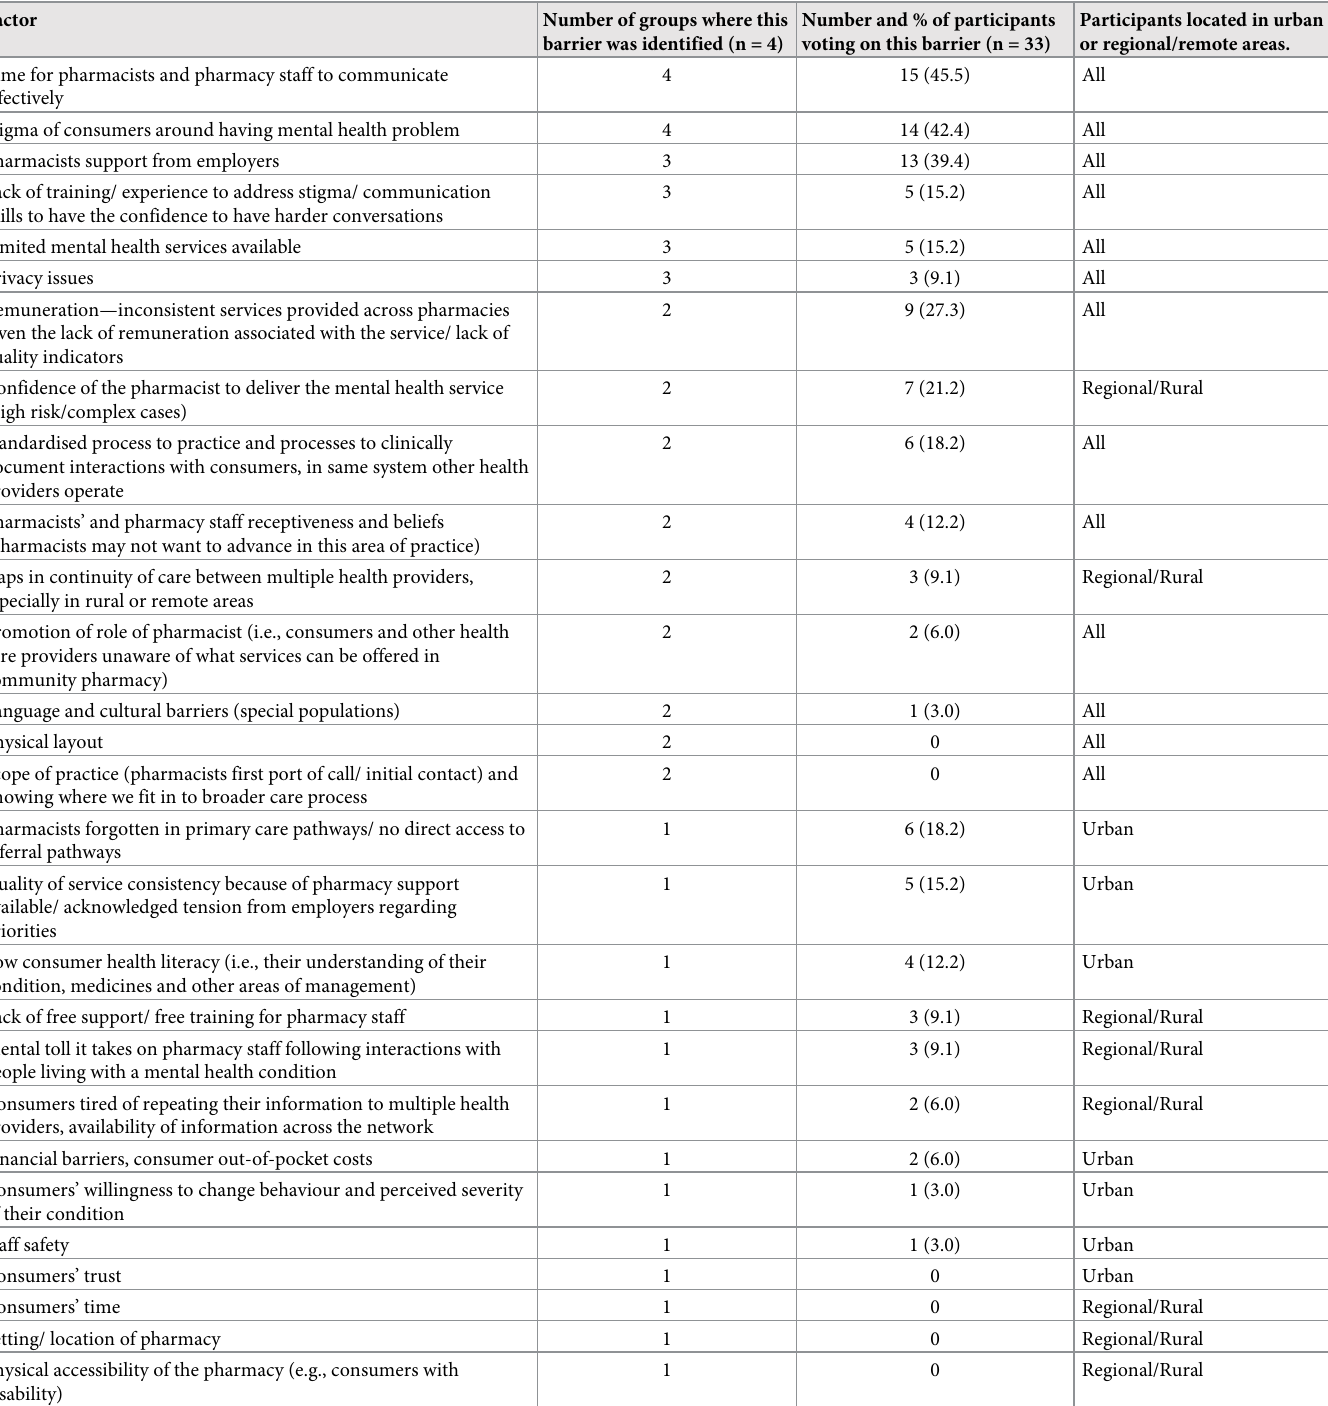
Table 4. Factors identified as barriers for the delivery of mental health services in community pharmacy. Factor Number of groups where this